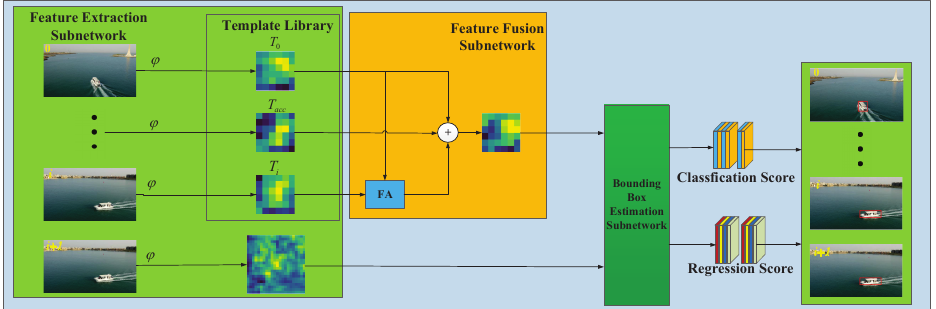
Figure 2. Schematic of the TDSiam framework. On the left is the feature extraction subnetwork. The feature fusion subnetwork is depicted in the middle, which is responsible for fusing the information from the template library. On the right is the bounding box estimation subnetwork, which has two branches, one is in charge of foreground–background classification, and the other is used for bounding box